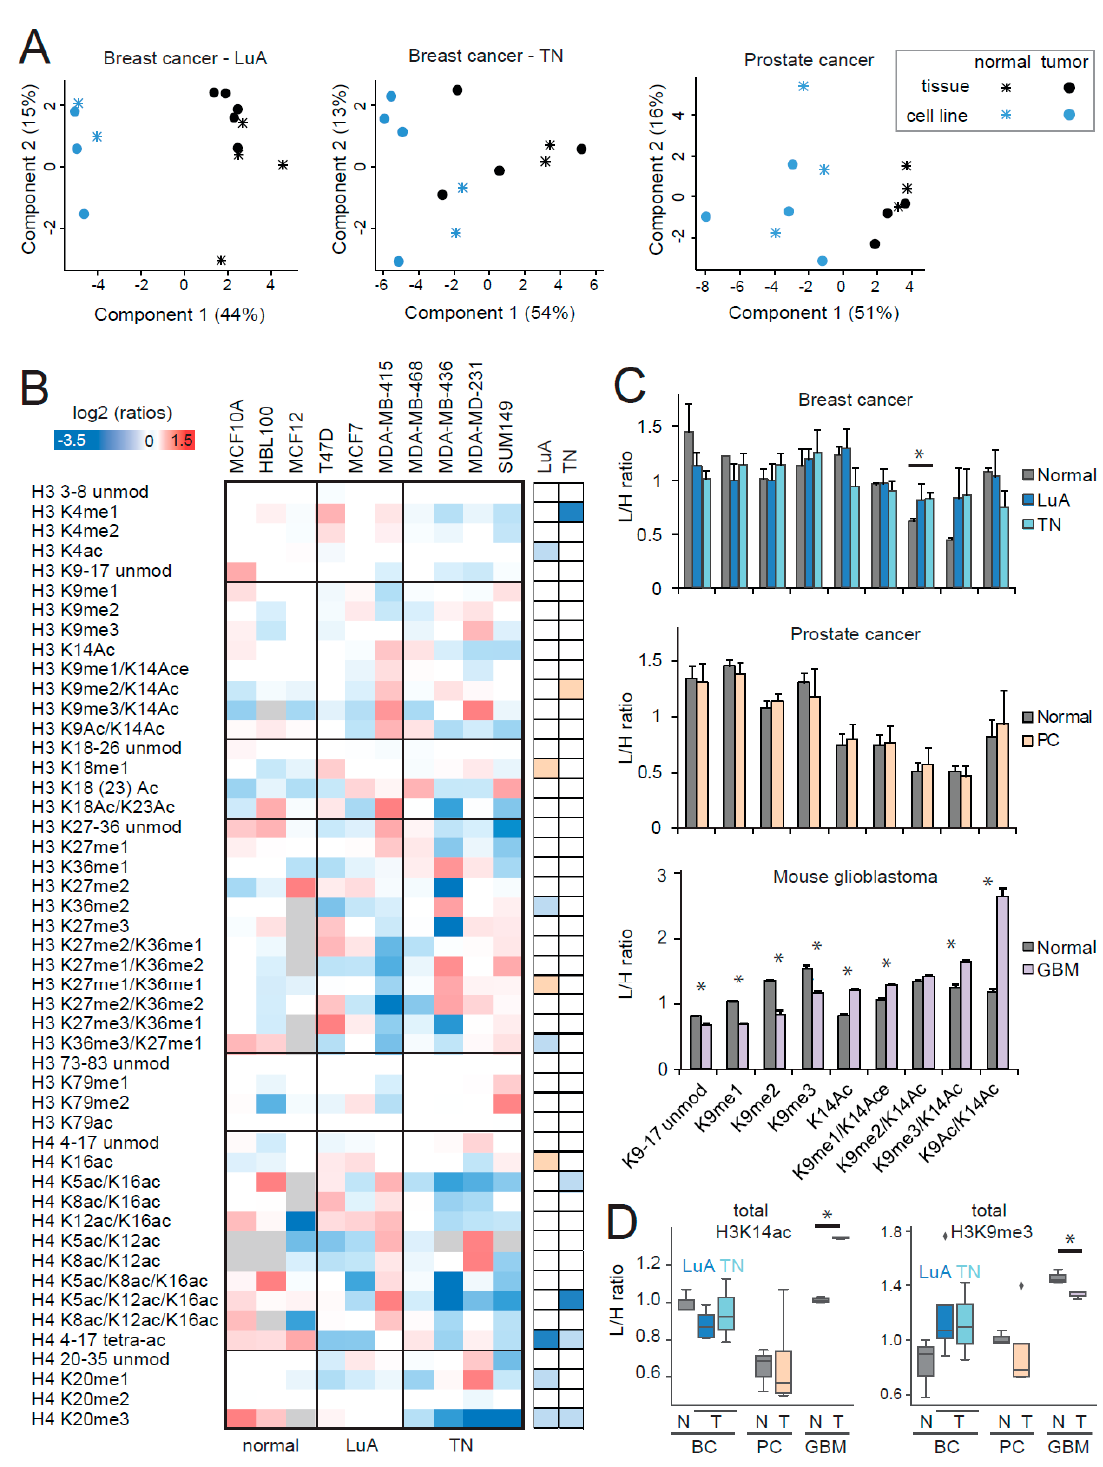
Figure 6. Histone post-translational modifications (PTM) profiling of normal and tumoral cell lines. ( A ) Principal component analysis of normal and tumoral tissues and cell lines for the luminal A-like and triple negative breast cancer and prostate cancer models. The grey color indicates peptides that were not quantified. ( B ) Heatmap display of the log2 transformed ratios obtained for the indicated histone PTMs in normal and tumor breast cell lines. Tumoral cell lines were divided in luminal A (LuA) and triple negative (TN) and were analyzed separately. L / H (light / heavy) relative abundances ratios obtained with the super-SILAC strategy (light channel: Normal / tumor cell line, heavy channel: Spike-in super-SILAC standard), normalized over the average value across all the samples. Some of the data for histone H3 PTMs is from [13] (see dataset S1). Right panel: Modified peptides were